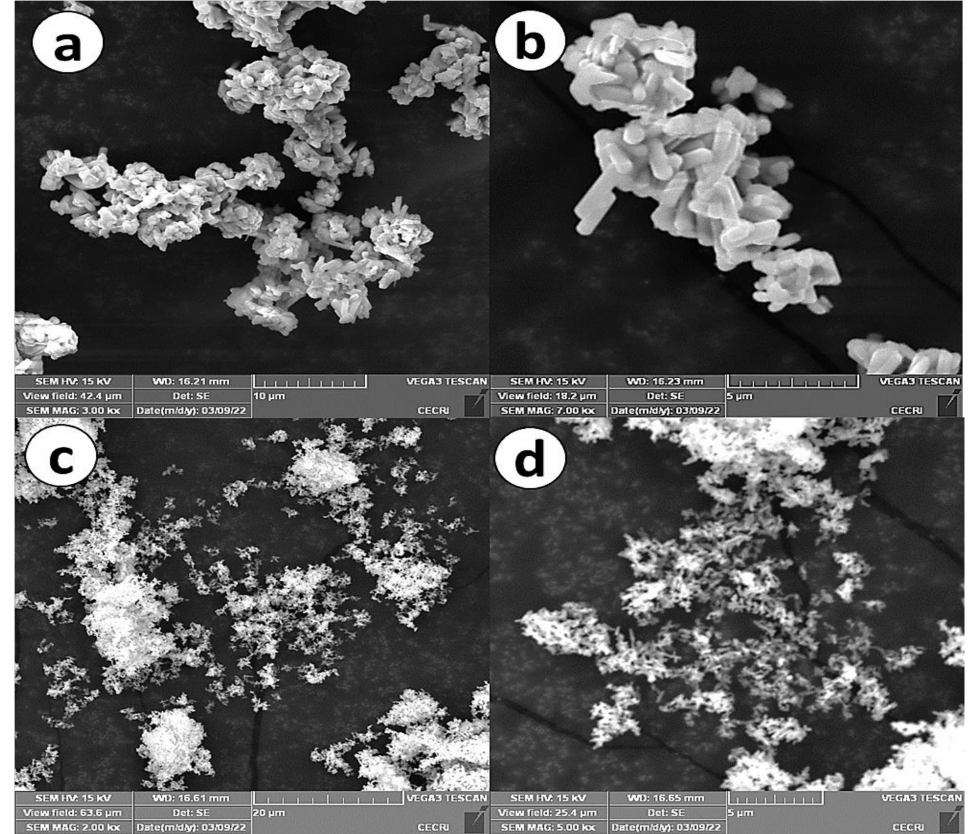
Figure 3. ( a ) SEM images (low magnification) of Cu 3 Mo 2 O 9 @DNA; ( b ) SEM images (high magni- fication) of Cu 3 Mo 2 O 9 @DNA; ( c ) SEM images (low magnification) of Cu 3 Mo 2 O 9 @CTAB; ( d ) SEM images (high magnification) of Cu 3 Mo 2 O 9 @ CTAB.